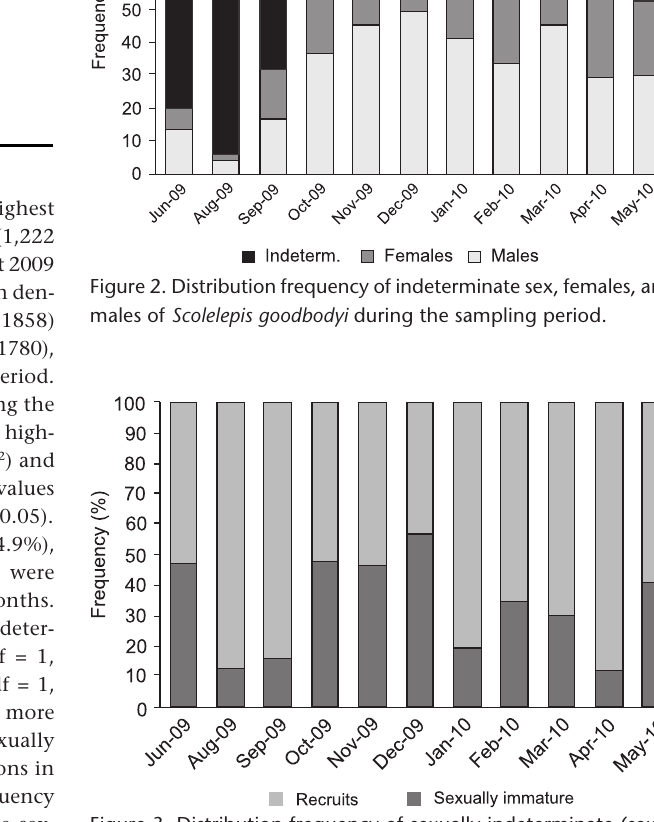
Figure 3. Distribution frequency of sexually indeterminate (sexu- ally immature and recruits) Scolelepis goodbodyi individuals during the sampling